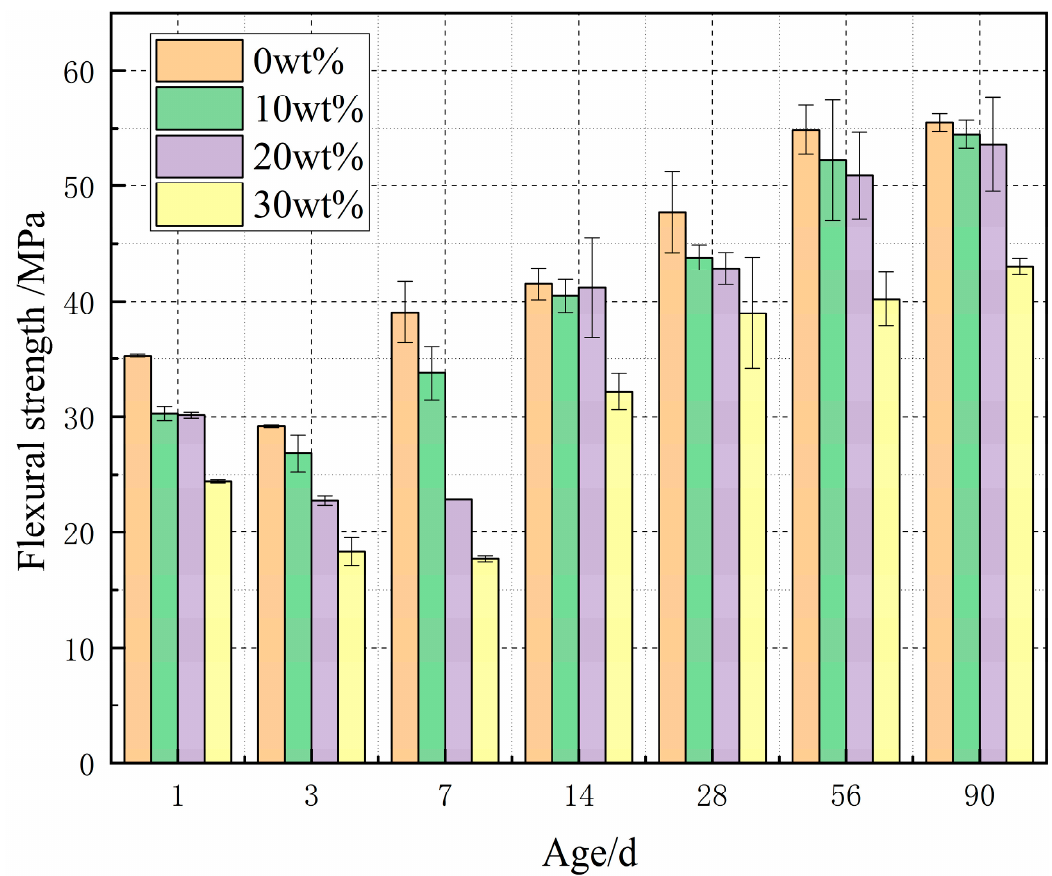
Figure 5. Compression change data graph of pure paste specimens with different dosages. According to the TG curves shown in Figure 6, the mass loss of Mg(OH) 2 at this temperature can be known, and the amount of Mg(OH) 2 formed in cement paste and the hydration degree of MgO can be calculated by Equations (6) and (7). = Mass Mg ( OH ) 2